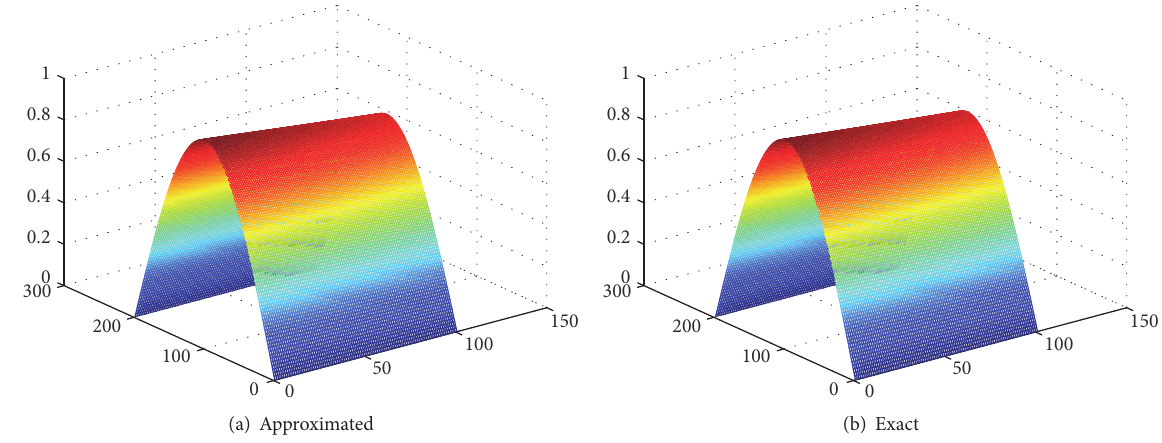
Figure 3: Graphics of the approximated and exact solutions for 𝑡 ∈ [0,0.1]